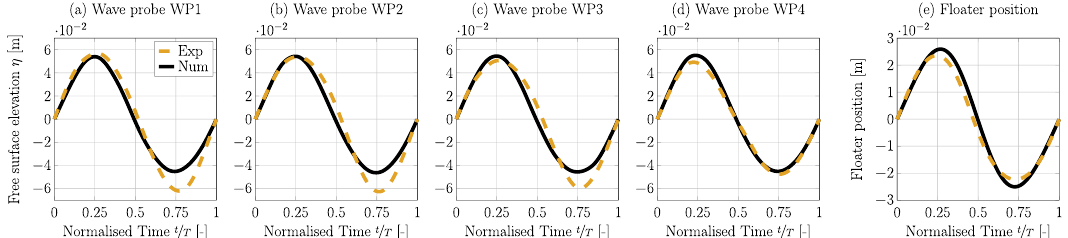
Figure 23. Phase-averaged free surface elevation, measured at wave probes WP1–WP4 ( a – d ), and floater position ( e ) for wave